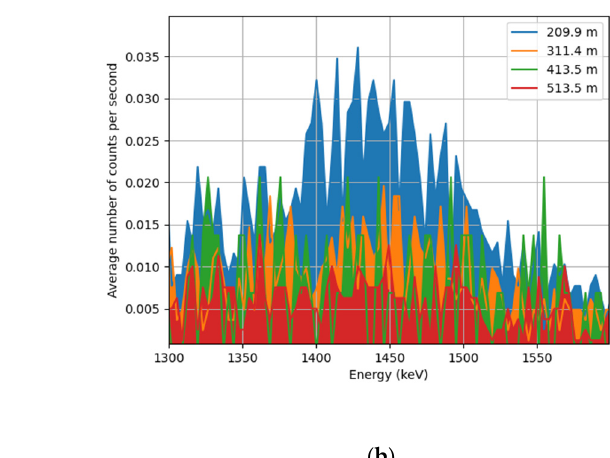
Figure 11. ( a ) Average number of counts per second at different heights shown on a logarithmic scale. ( b ) Average number of counts per second at different heights zoomed in on the K-40 peak (1460 keV) on a linear scale.